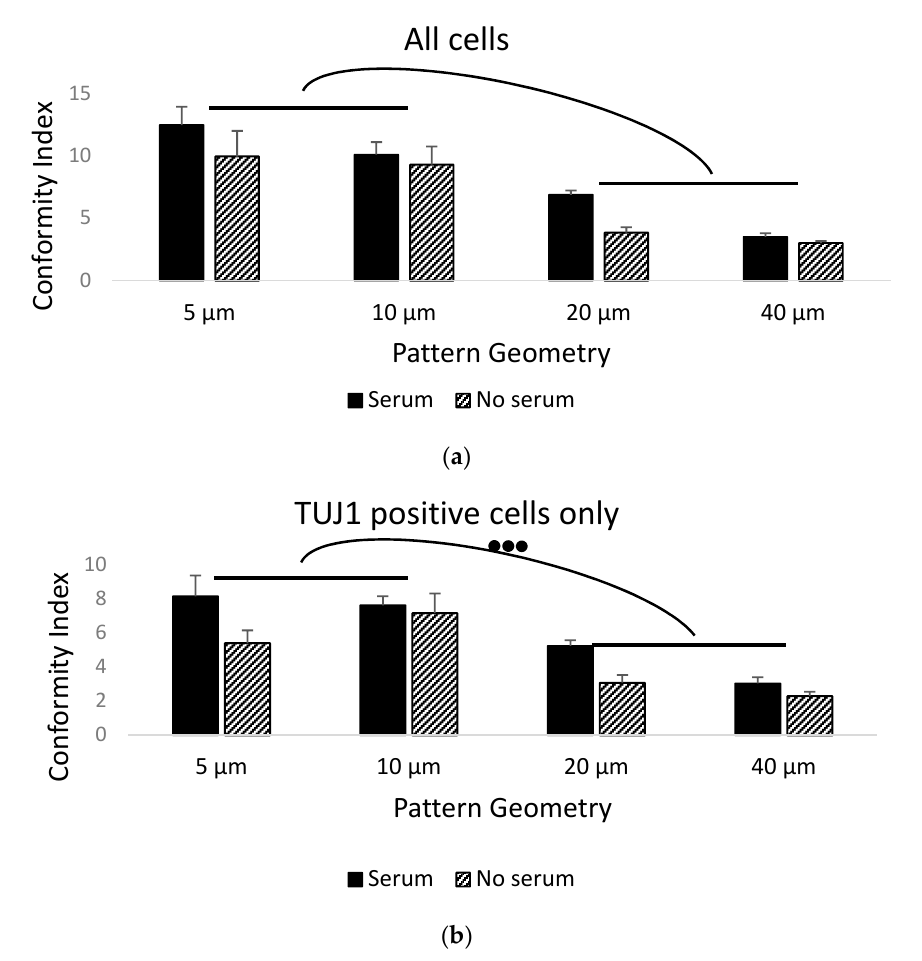
Figure 2. Bar graphs of the conformity index of: ( a ) all cells patterned on parylene-C and ( b ) TUJ1 + cells patterned on paryelene-C. Black bars denote the average CIs of serum-treated samples ( N = 8), whereas stripped bars denote the average CIs of untreated samples ( N = 4). Results highlight the importance of serum in mESC and TUJ1 + cell patterning, as well as narrower geometries being superior at guiding cellular migration and growth. Three dots denote significance at p < 0.001 between the depicted geometry groupings. Error bars represent the standard error of the mean (SEM).